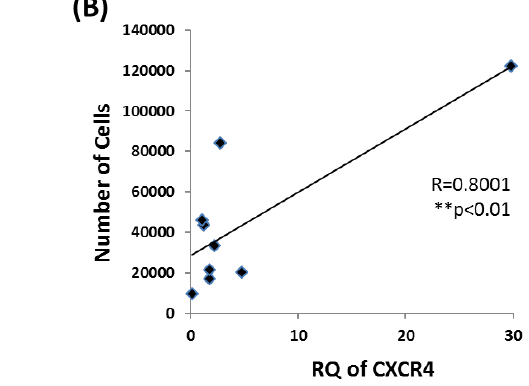
Figure 4. EPCs expression levels of angiogenic and chemoattractant genes. ( A ) mRNA expression of ( a ) SDF-1 ( b ) VEGF-A ( c ) CCL2 ( d ) PDGFB ( e ) VEGFR-2 ( f ) CXCR4 genes. RQ values were normalized to donor 2. ( B ) Positive correlation between SDF-1 and CXCR4 expression levels between all donors, R = 0.948 **** p < 0.0001. ( C ) and after excluding outlier results, R = 0.937 ** p < 0.01.